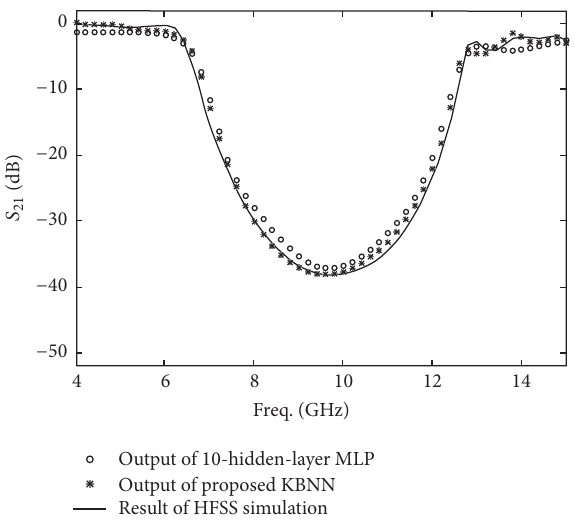
Figure 6: Test sample result of tapered dual-plane EBG.